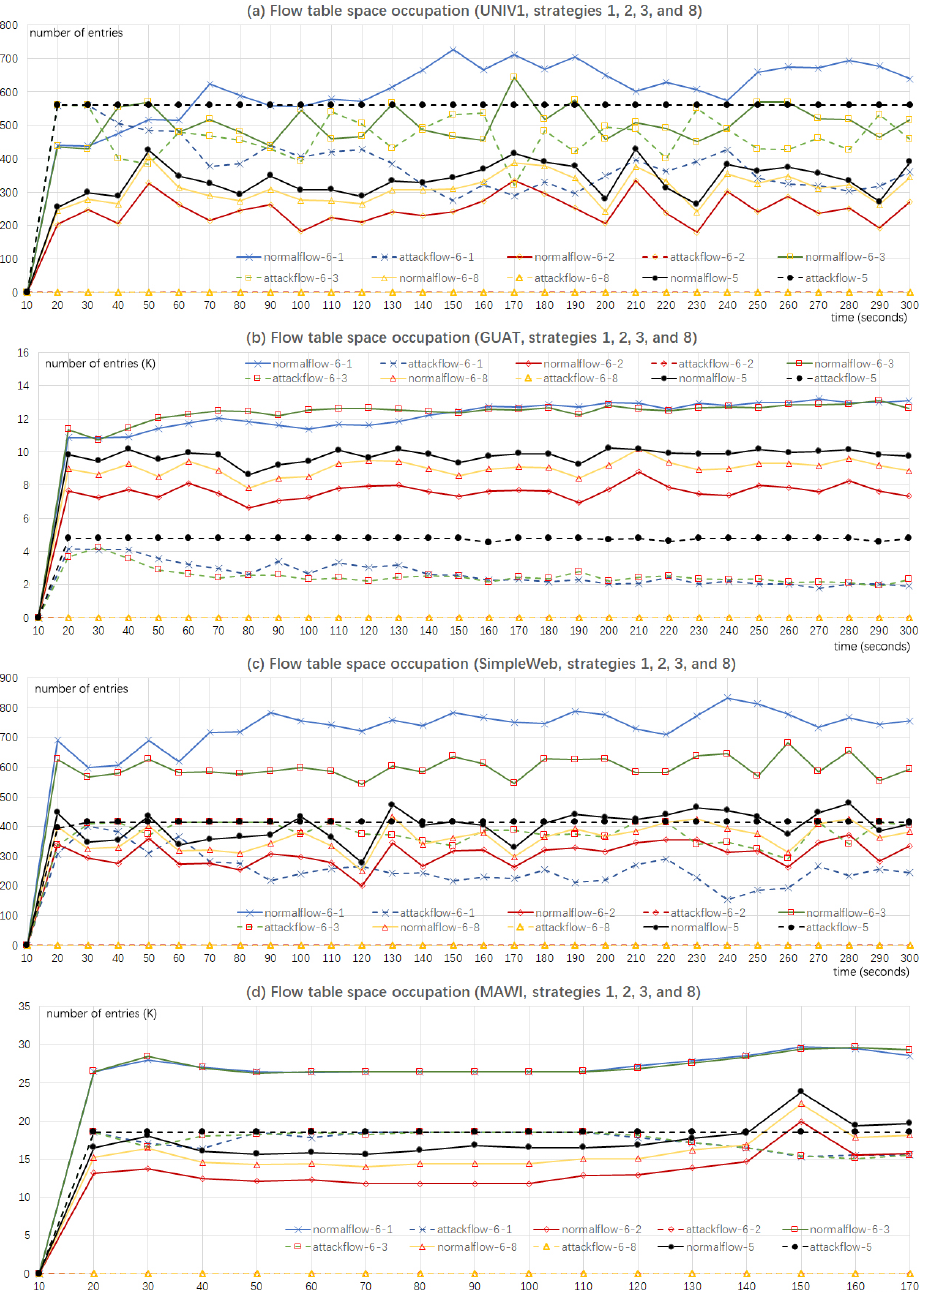
Figure 8. The real-time flow table usage under LDoS attack with flow-table constraints. The item normalflow(attackflow)-6-1 indicates the number of flow entries of the normal (attack) flows with strategy 1 involved in test scenario